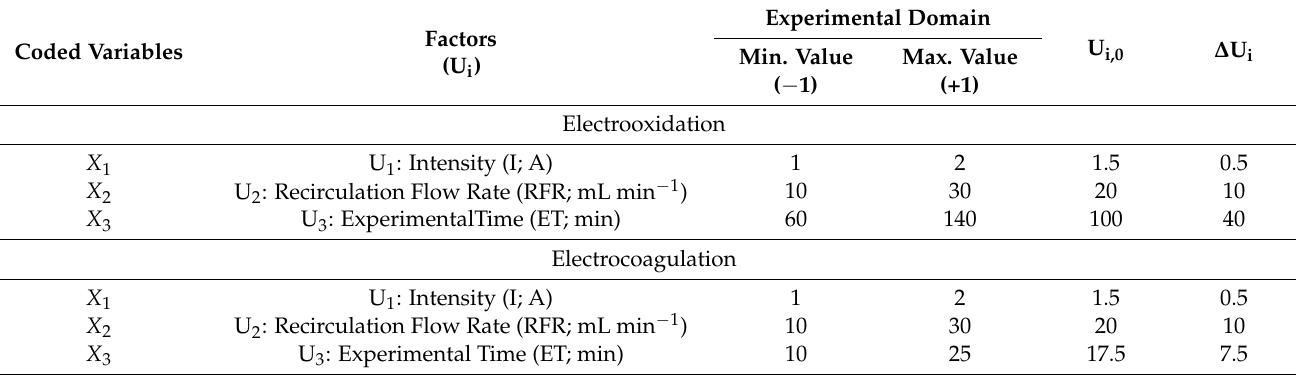
Table 1. Experimental matrix and values of independent